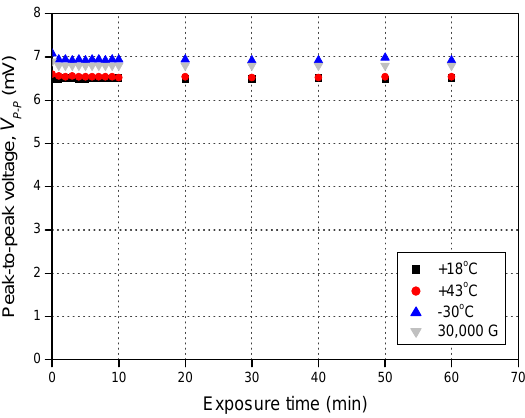
Figure 15. Measured drifts of fabricated MMIS at magnetic flux density of 0.05 mT and frequency of 500